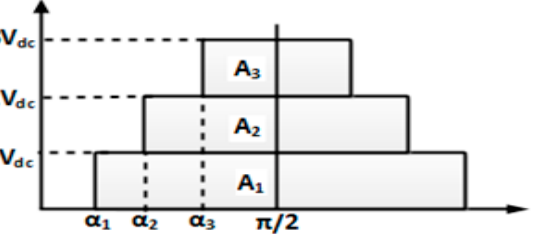
Figure 10. Output phase-voltage of a seven-level DCLCHB inverter in the positive half-cycle voltage.